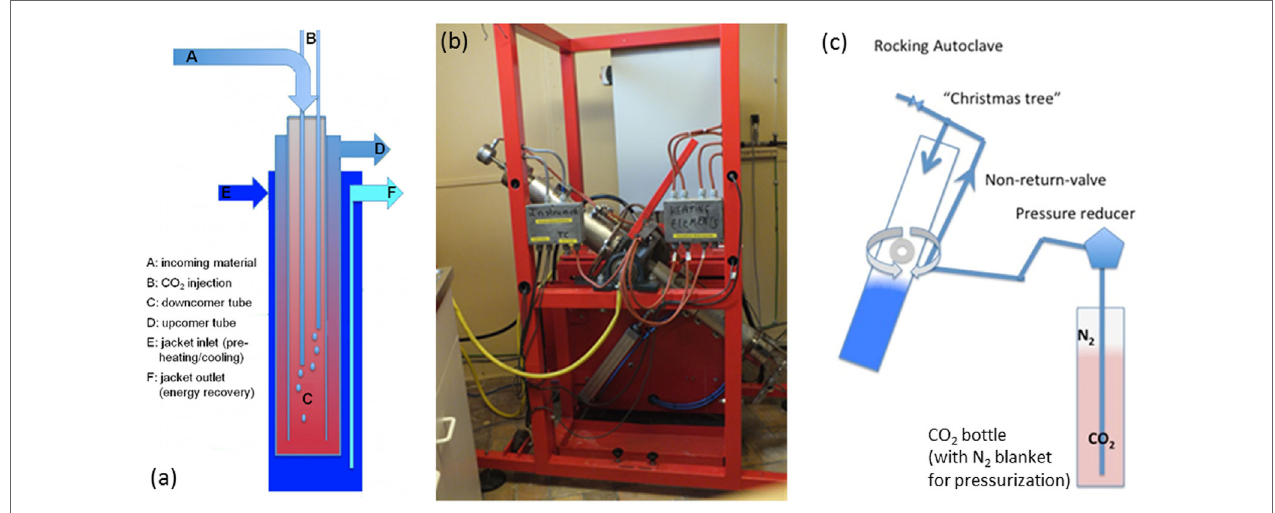
FiGUre 1 | (A) Conceptual layout of “CO 2 Energy Reactor ™ ” (not to scale) (Santos et al., 2013, licensed under CC BY-NC-ND 3.0); (B) lab-scale “rocking autoclave” at ~45° rotation; (c) schematic of “rocking